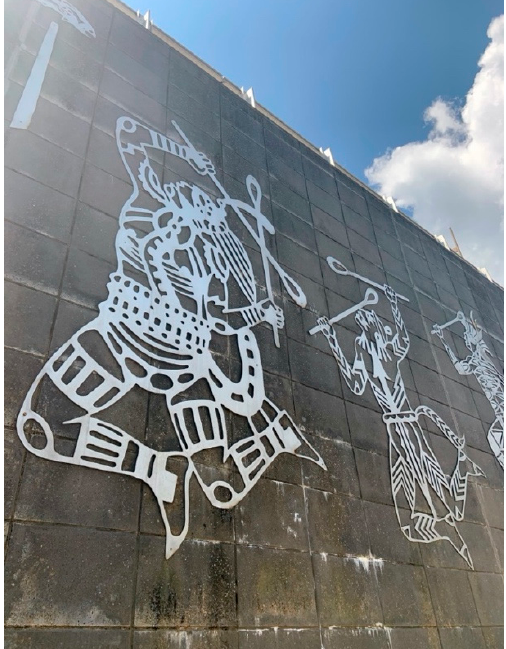
Figure 5. Cherokee stickball players on the edge of the Tennessee River in Chattanooga, Tennessee, are part of public art project “Passage,” by Team Gadugi (“Working Together” in Cherokee). The site, formerly known as Ross’s Landing, was the beginning of the Trail of Tears. After the federal government’s Indian Removal Act was passed in 1830 during Andrew Jackson’s presidency, thousands of Cherokee were forced to walk to Indian Country in what is now Oklahoma.